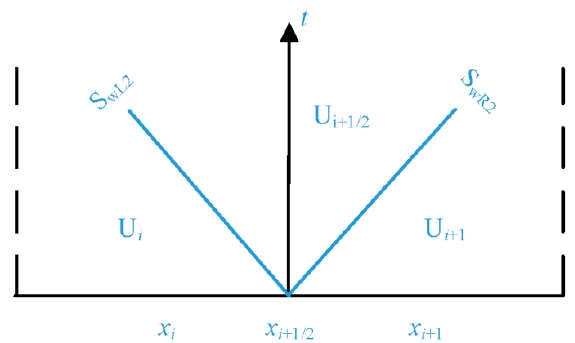
Figure 9. A left shock wave with a right shock wave at x i + 1 / 2 .